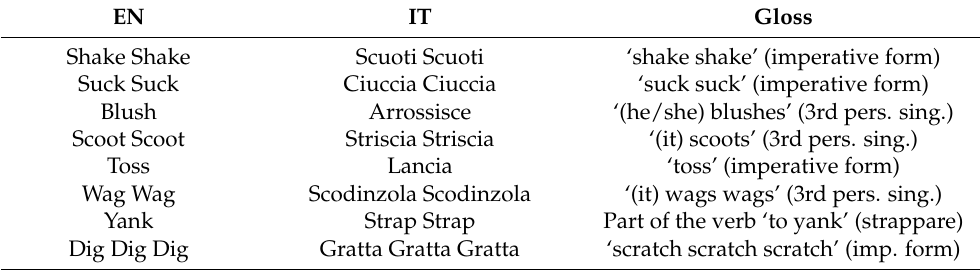
Table 6. Examples of Italianisations of English lexicalised